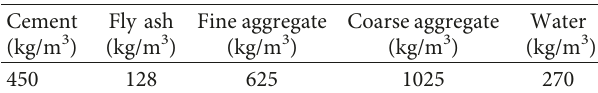
Table 3: Concrete mixture proportions used in the study.